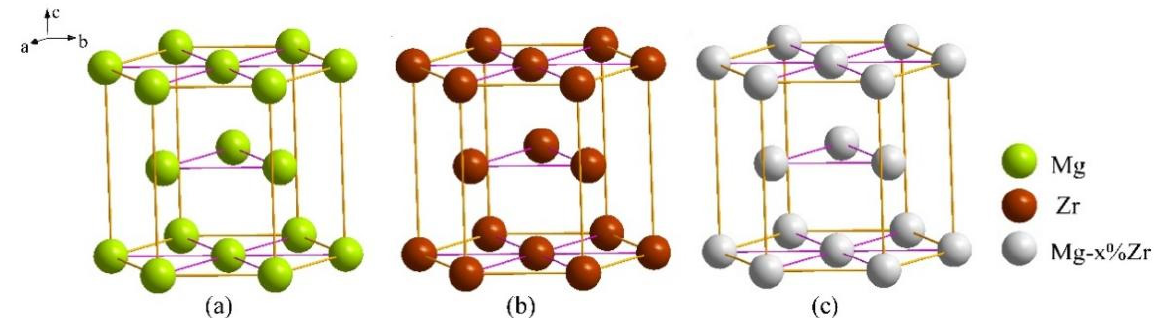
Figure 1. VES analysis models of ( a ) Mg, ( b ) Zr, ( c ) Mg-doped Zr (Mg– x Zr) structure unit. Table 1. Calculated VES parameters, bond energies, and cohesive energies for Mg and Zr.